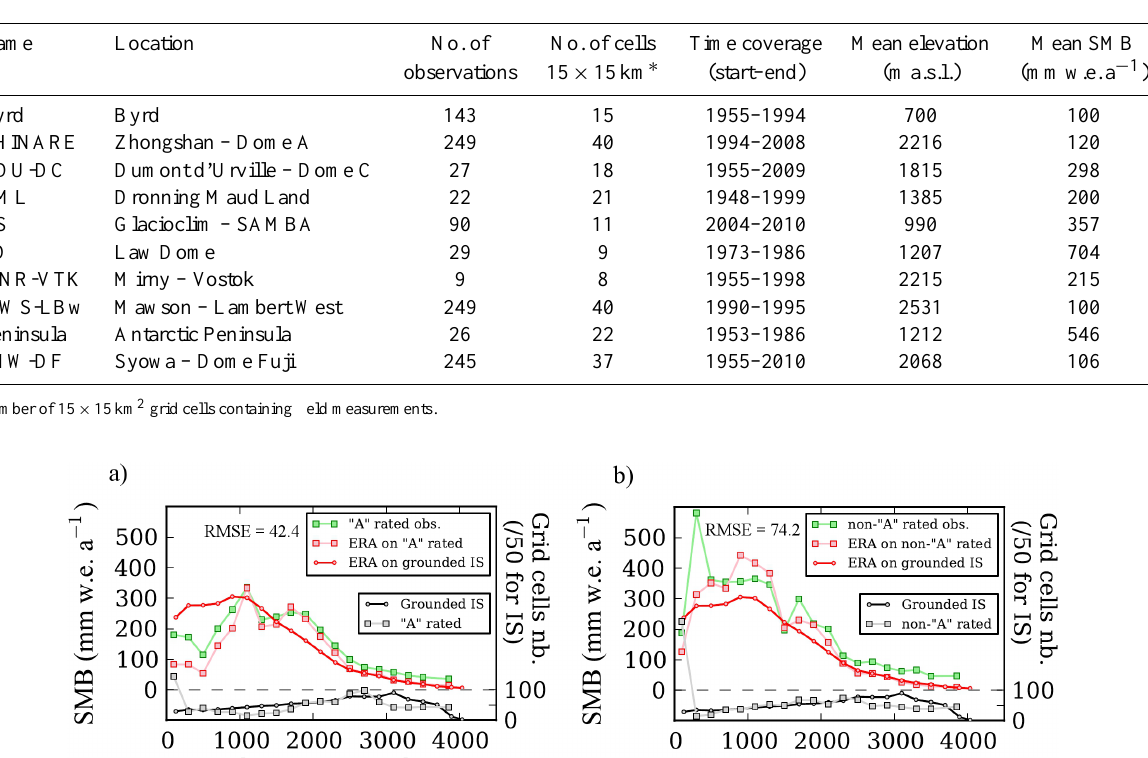
Table 5. Description of selected datasets in low elevation areas for comparison with ERA-Interim reanalysis.